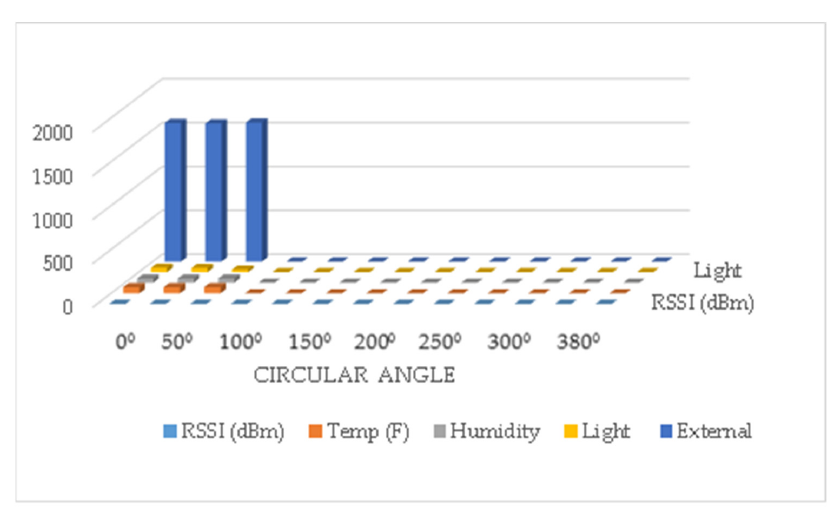
Electronics 2023 , 12 , x FOR PEER REVIEW 18 of 26 Figure 10. 250° Sense Data from Patch Antenna. Figure 10. 250° Sense Data from Patch Antenna. Figure 10. 250 ◦ Sense Data from Patch Antenna.